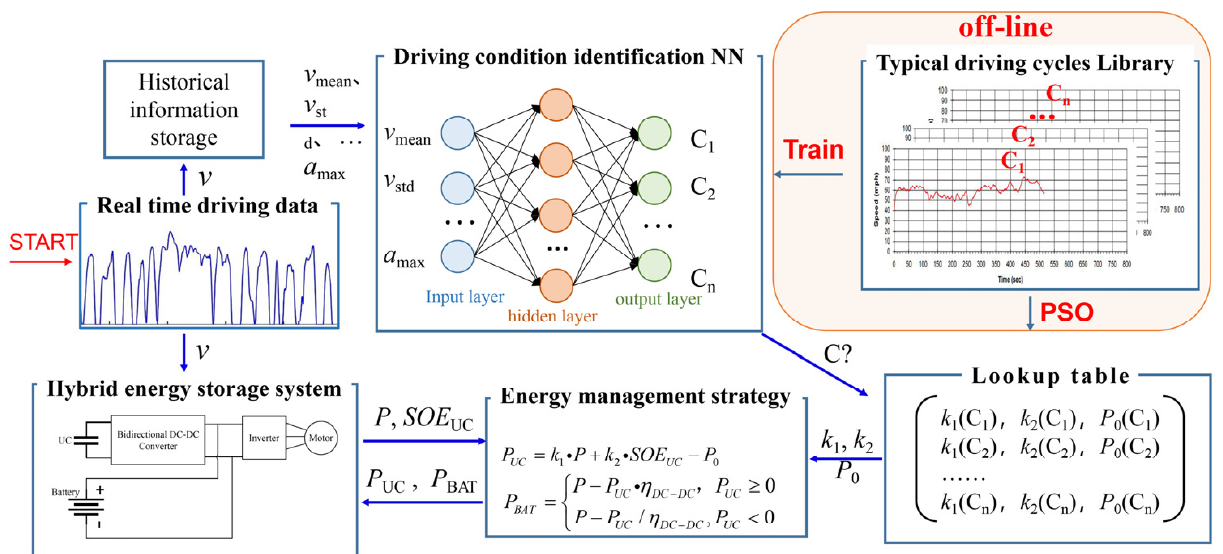
Figure 4. The detailed flow of the proposed power distribution strategy.